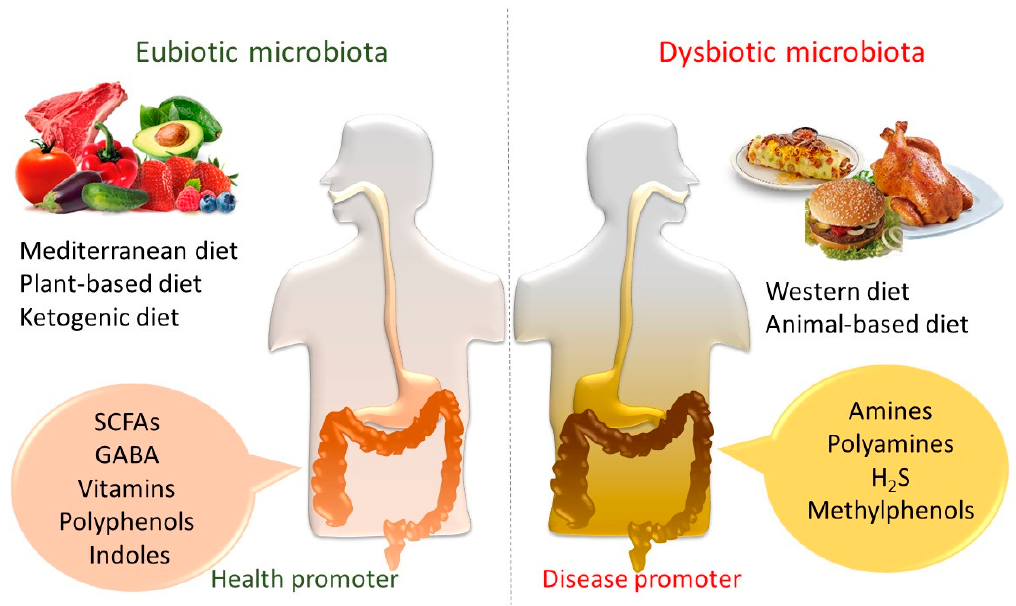
Figure 1. Dietary effect on gut microbiota and health. The gut microbiota takes part in the digestion of food ingredients and in the regulation of host metabolic functions. The nutrient-dependent impact of commensal bacteria to the eubiosis and dysbiosis, thereby the health and disease status, is caused by the production of several microbial metabolites.